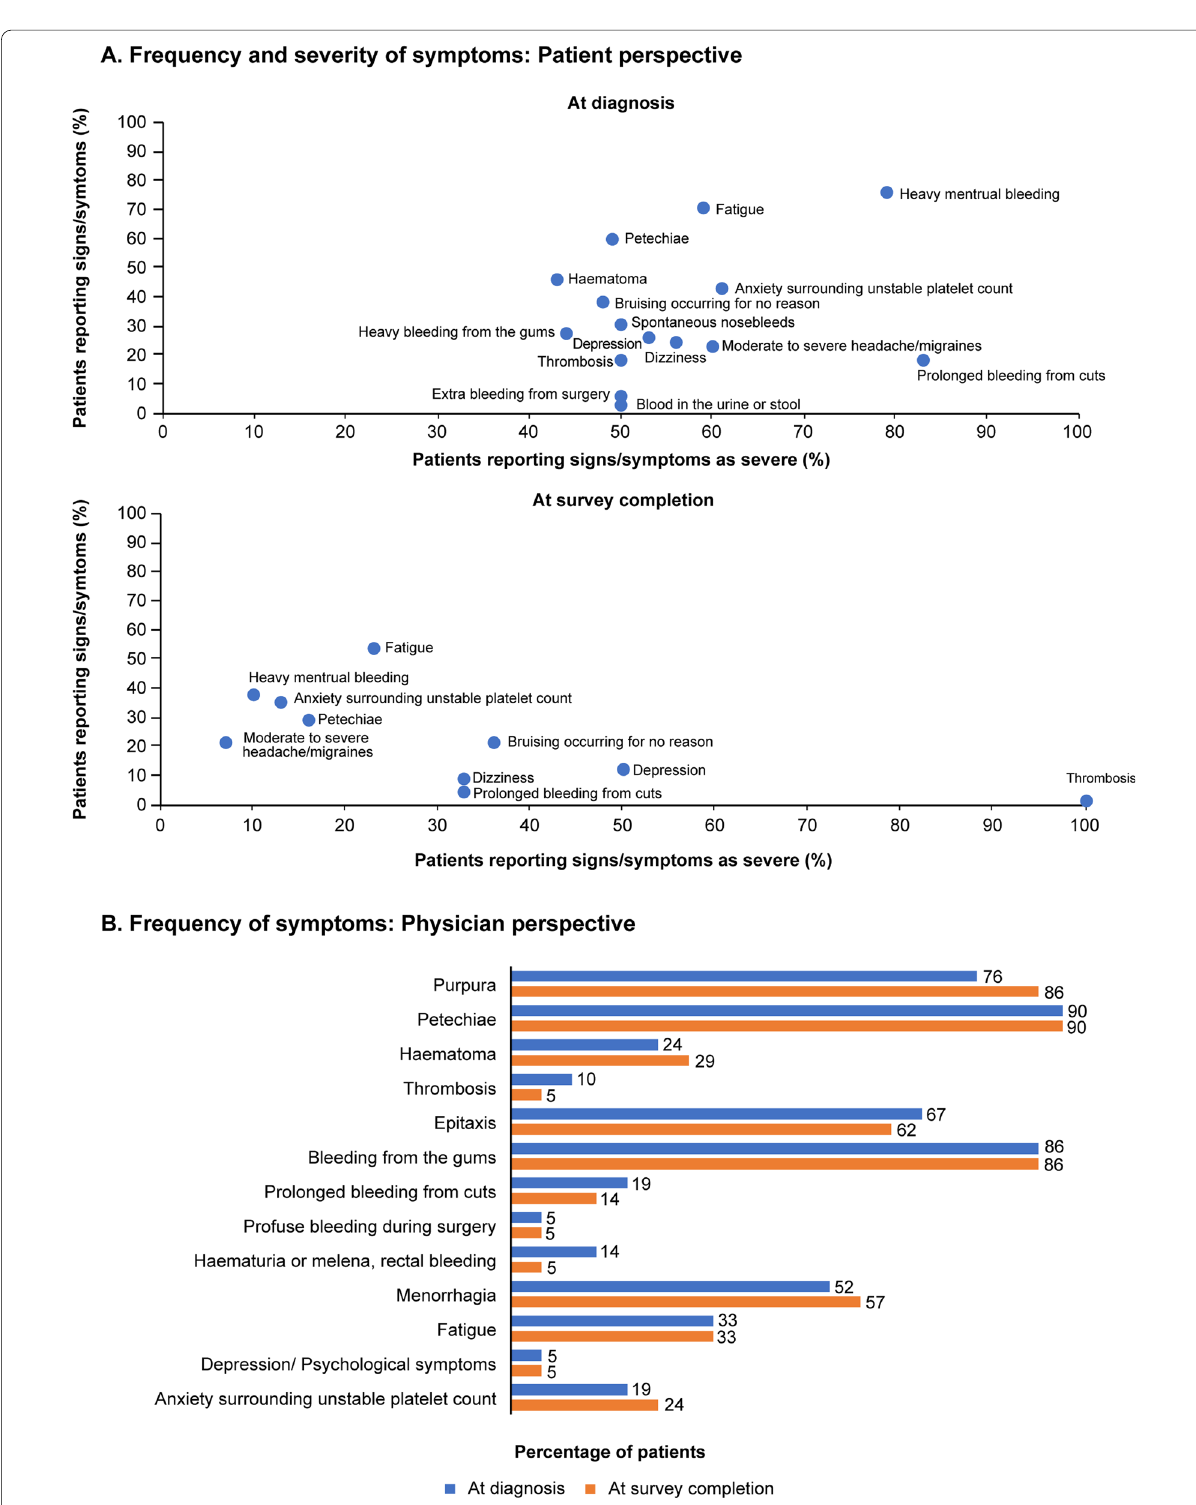
Fig. 1 Frequency and/or severity of symptoms of ITP at diagnosis and survey completion – Patient and physician